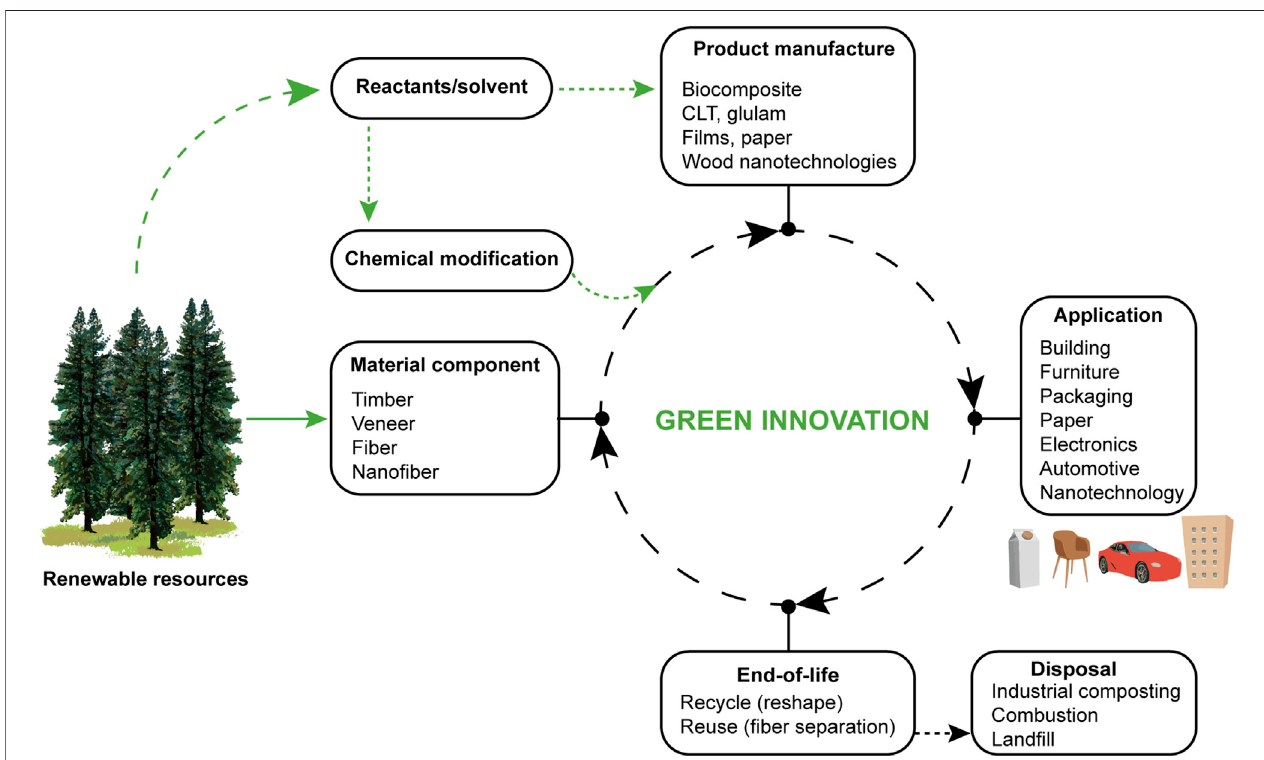
FIGURE 1 | Life cycle for wood-based biocomposites. Sustainable development requires that cumulative energy demand and carbon dioxide emissions are decreased, compared with existing materials.